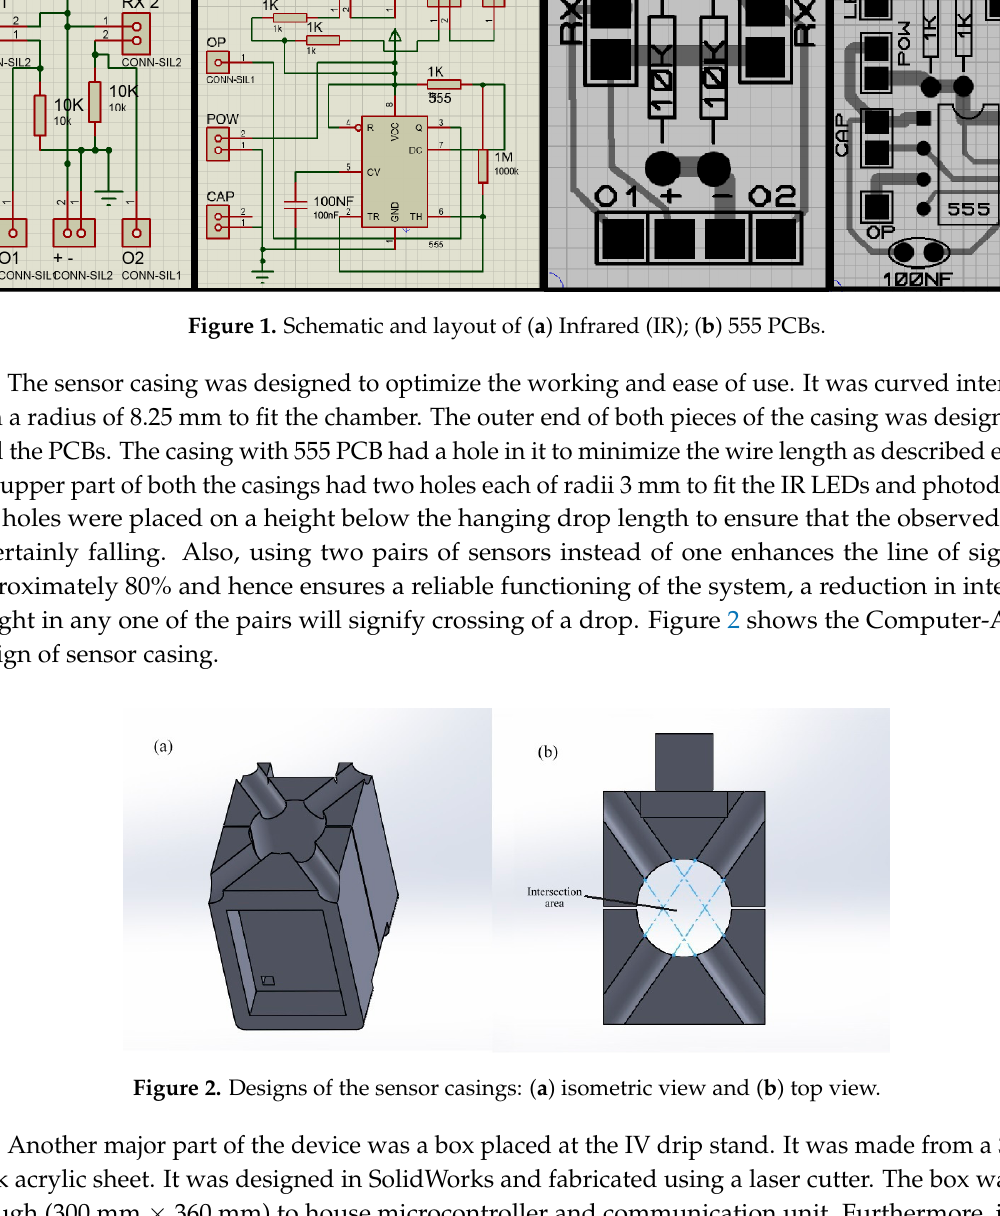
Figure 2. Designs of the sensor casings: ( a ) isometric view and ( b ) top view.